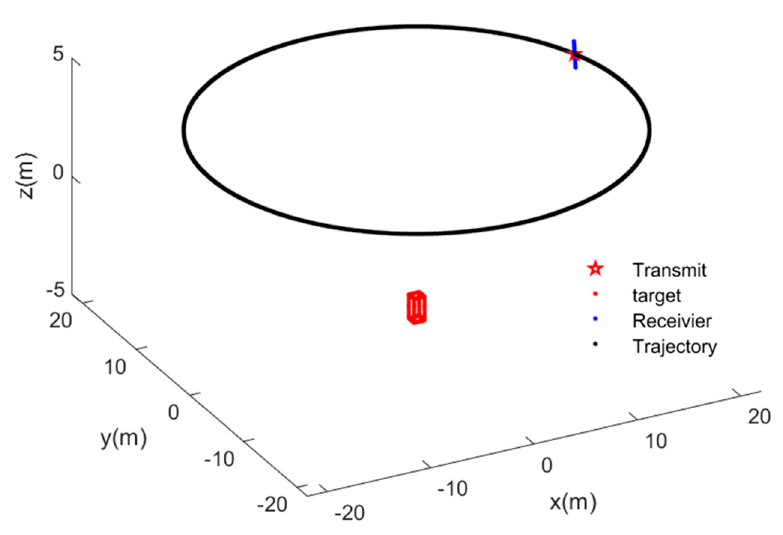
Figure 6. The image scene of circular array synthetic aperture sonar.